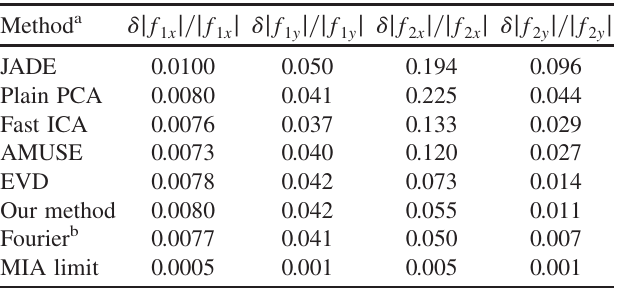
TABLE I. Our method compared to several ICA algorithms and conventional harmonic analysis of turn-by-turn data. This table shows the errors of determination of betatron